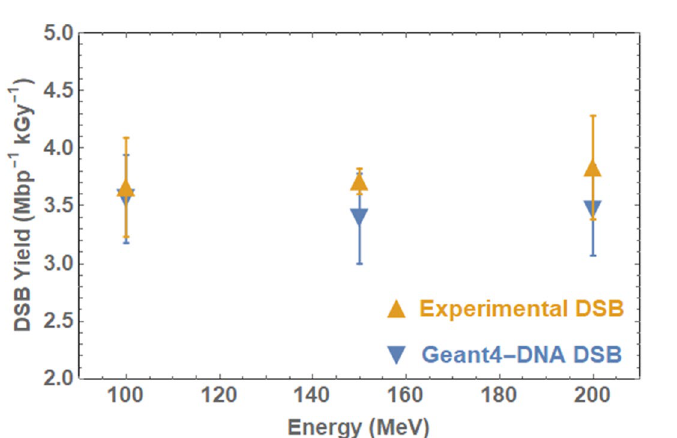
Figure 3. RBE values for ( a ) VHEE and protons with dry plasmid DSB yield as the biological endpoint and ( b ) VHEE, low-energy electrons and protons with wet plasmid DSB yield (Small, Vysin, CLEAR) or cell survival fraction (Herskind, Spadinger, Zackrisson) as the biological endpoint. Experimental data taken from references 35–38 .